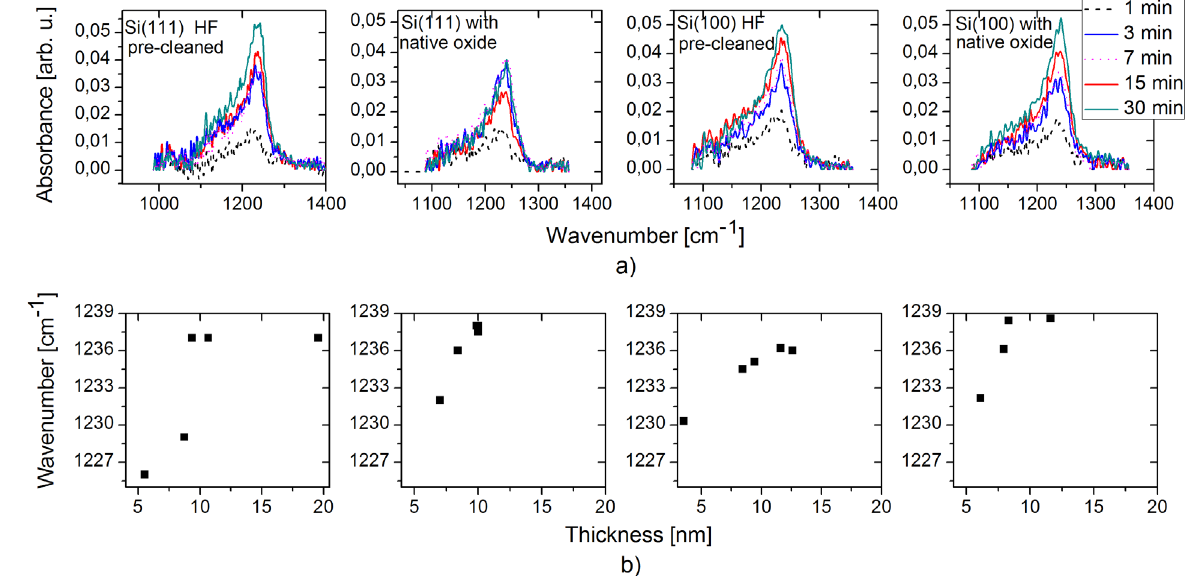
Figure 4 : a) Si-O-Si peak at ~1240 cm -1 representing LO mode of Si-O-Si vibration of the oxidized layers after various treatment time and conditions b) corresponding peak shift maximum in dependence on the thickness of oxide